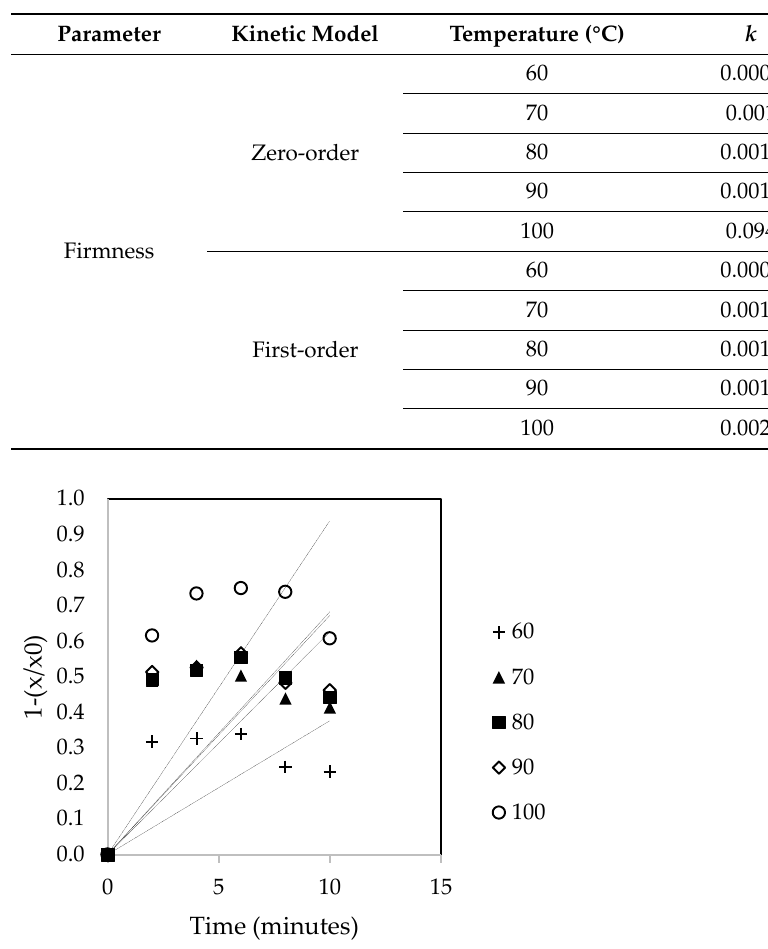
Table 2. The reaction rate ( k ) and coefficient of determination (R 2 ) of the zero-order kinetic model, first-order kinetic model and fractional conversion order model, of changes of firmness of Dabai fruit due to blanching.